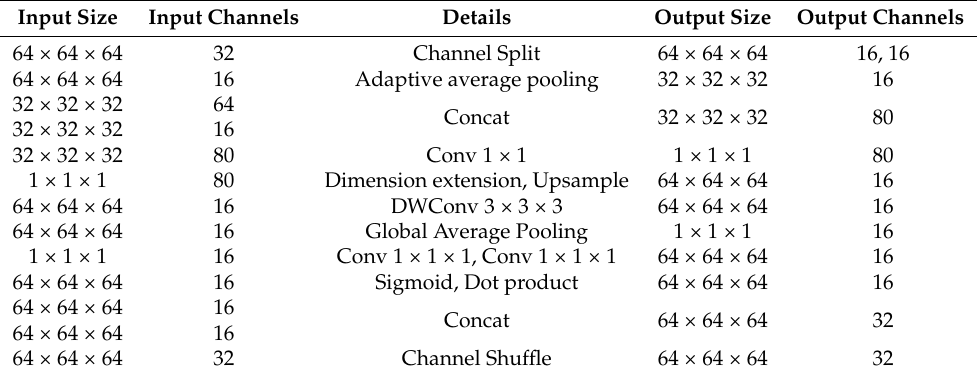
Figure 2. The structure of LCC block. First, the input channels are split into two branches by a channel-splitting operation. The main branch runs a channel weighting unit (CWU), 3 × 3 × 3 depthwise separable convolution (DWConv), and spatial weighting unit (SWU). The other branch is mapped as constant. Table 2. The structure of LCC block. Take the first LCC block in Stage 2 as an